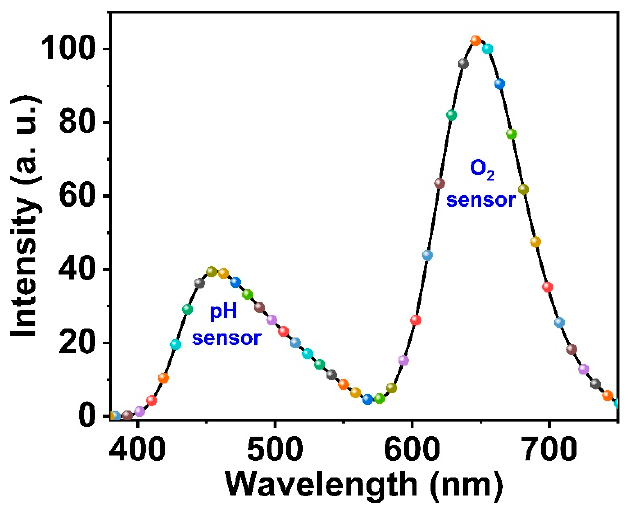
Figure 8. The emission spectrum of the ormosil nanosensor doped with Pt-TPFPP and immobilized with salicylamide under excitation with 365 nm.